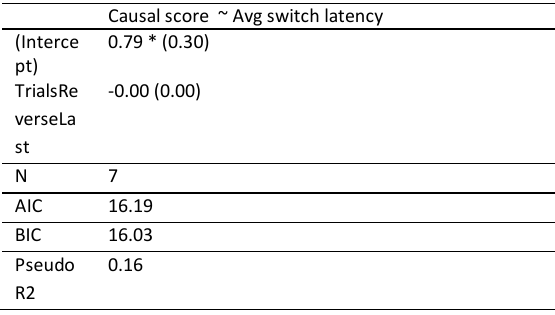
Table 3. Results from the GLM: causal score ~ average latency (seconds) to switch to attempting a new locus on the multiaccess log after having previously solved a different locus. The estimate and (standard error) are